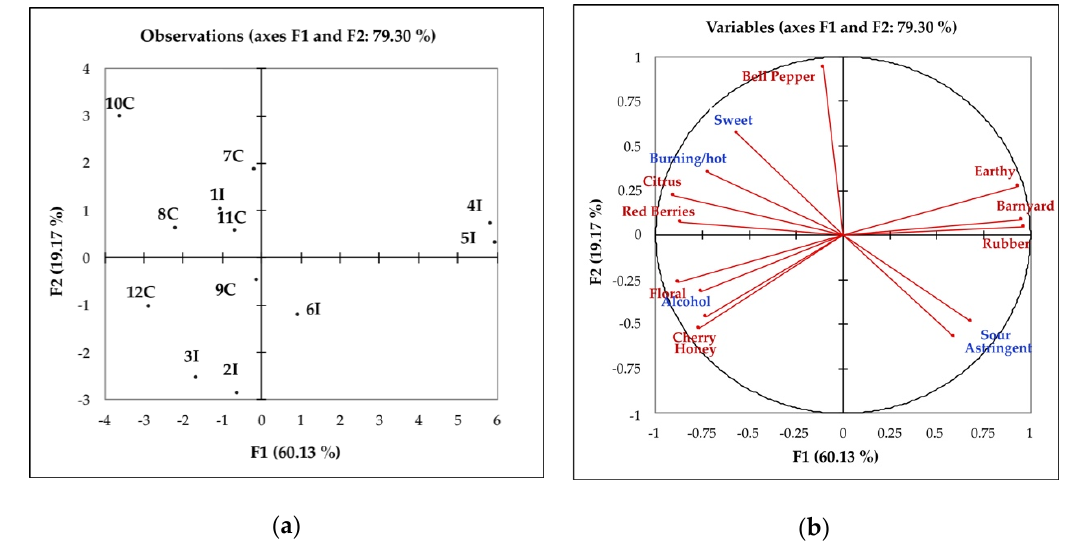
Figure 3. Principal component analysis (PCA) scores ( a ) and loadings ( b ) plots of eligibility (blue) and identity (red) profile (QDA sensory attributes) for Sangiovese wines from Italy and California from 2017 harvest. See Table 1 for the wine codes.